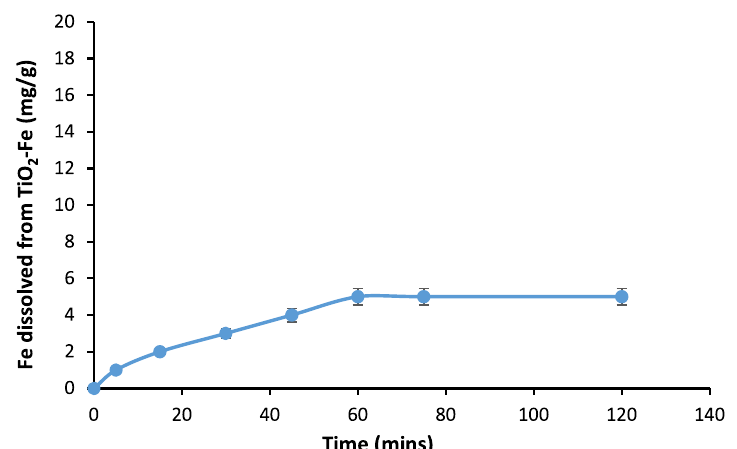
Fig. 12 The amount of the Fe dopant dissolved from the doped photocatalyst during the photocatalysis degradation